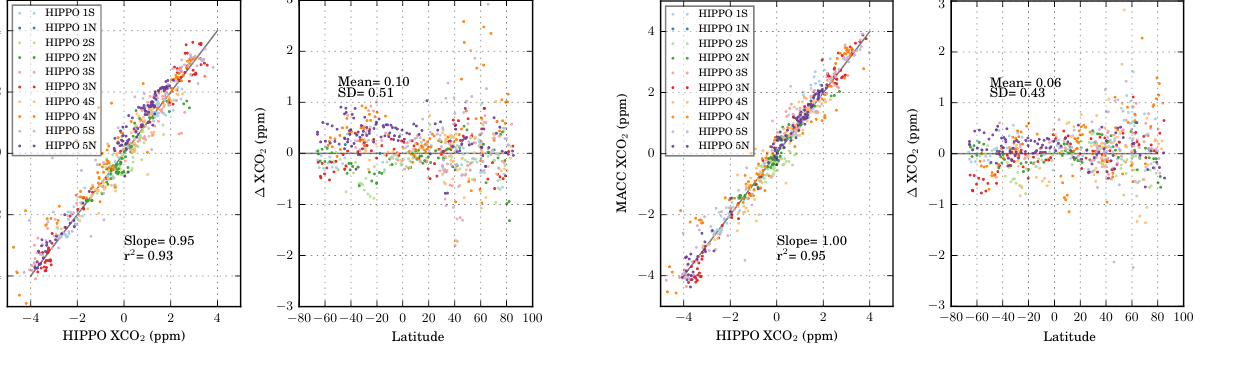
Figure 5. Left: scatter plot of normalized (with campaign aver- age) XCO 2 computed from individual HIPPO profiles ( x axis) against corresponding CT2013B data. Right: difference plot of XCO 2 against latitude. Campaigns as well as north and southbound tracks are color coded.